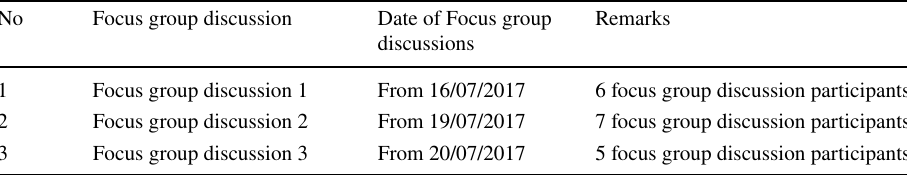
Table 3 The date of focus group discussion forums Source Addis Ababa Environmental Protection Authority